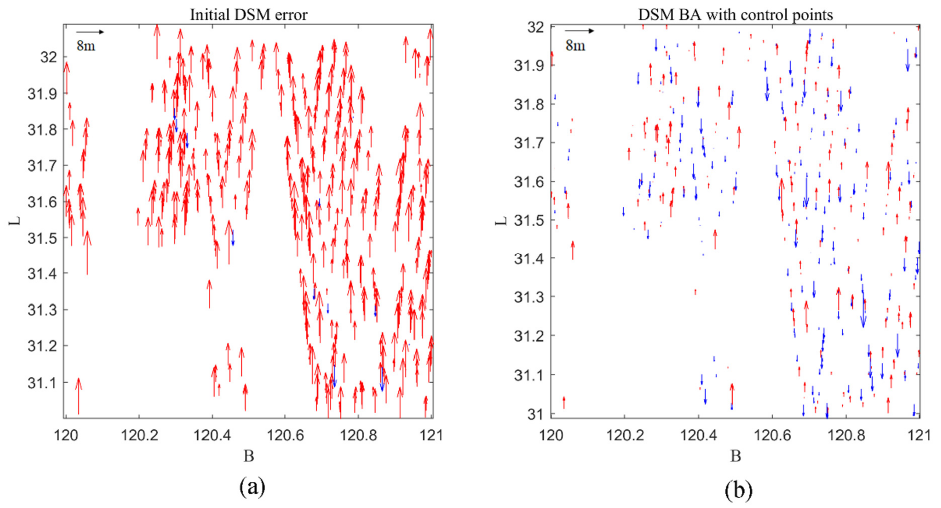
Figure 8. Elevation error distribution on the check points for the SRTM DSMs (positive errors are indicated by the up-pointing red arrows and negative errors by down-pointing blue arrows). ( a ) before block adjustment, and ( b ) after block adjustment.